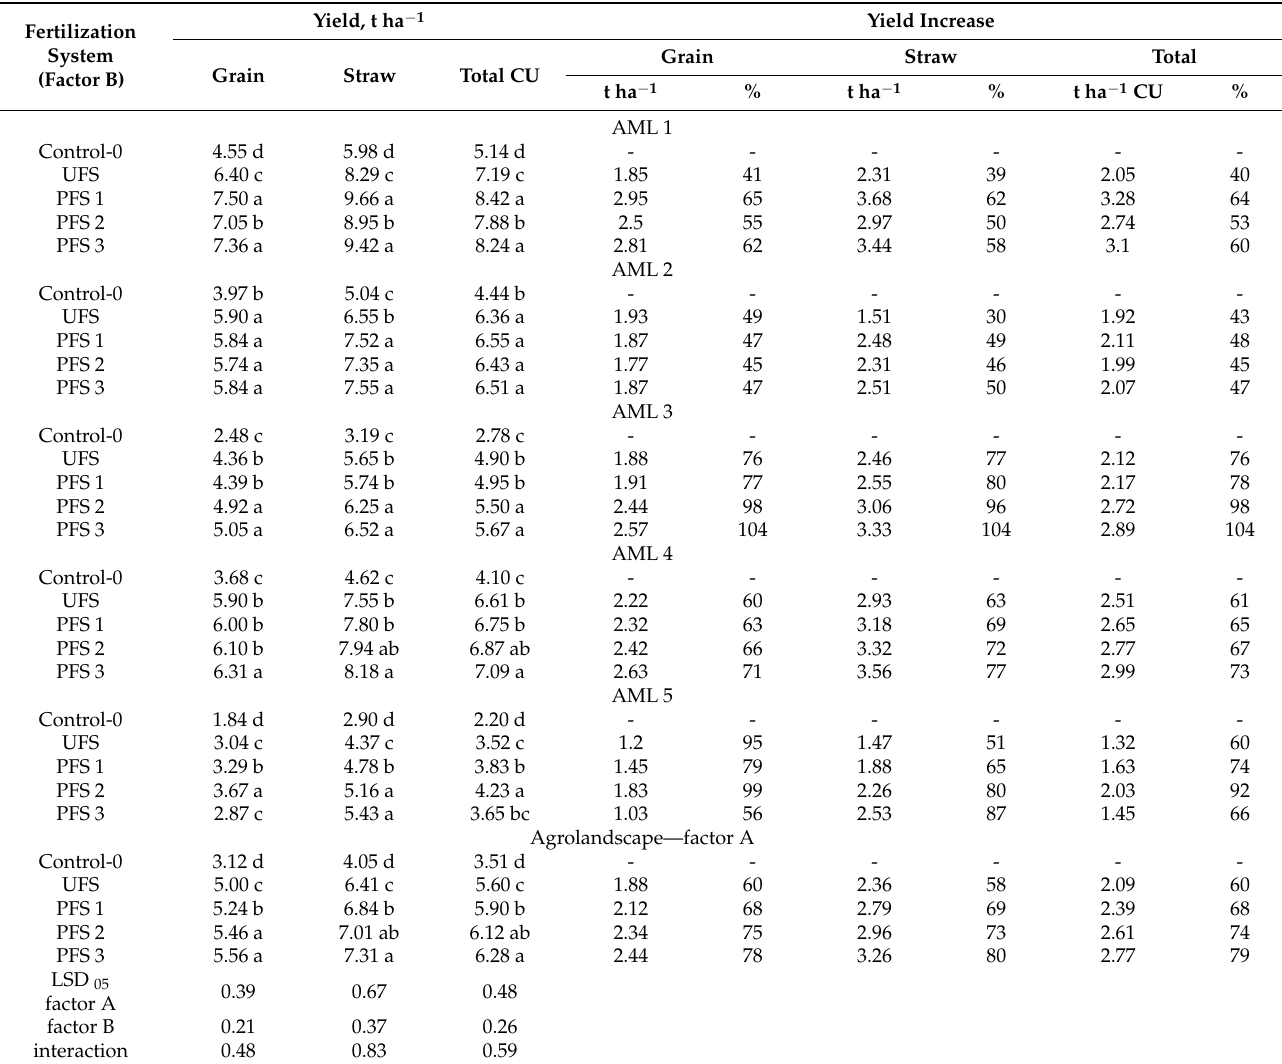
Table 5. Effect of AML conditions and fertilizer systems on oat